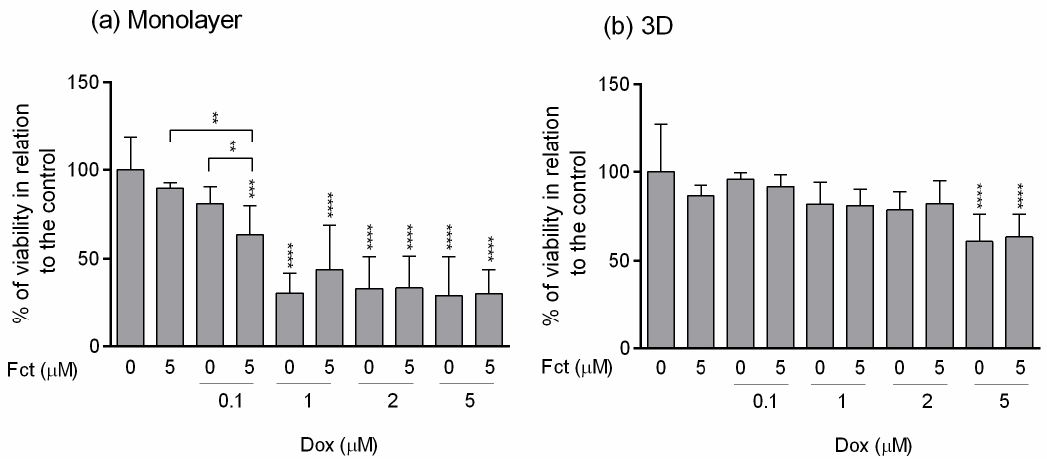
Figure 9. Effect of fucosterol (Fct) at 5 μ M alone and in combination with doxorubicin (Dox) at 0.1, 1, 2, and 5 μ M, on the viability of MDA-MB-231 cells in monolayer–72 h ( a ) and 3D–96 h ( b ) assessed by the resazurin assay. Cells treated with 0.1% DMSO and Dox 5 µ M were included as negative and positive controls, respectively. The percentages of cell viability are relative to the control and presented as mean + standard deviation of five independent experiments (each in triplicate). Square brackets indicate t tests with Sequential Bonferroni corrections (** p < 0.01, *** p < 0.001 and **** p < 0.0001).